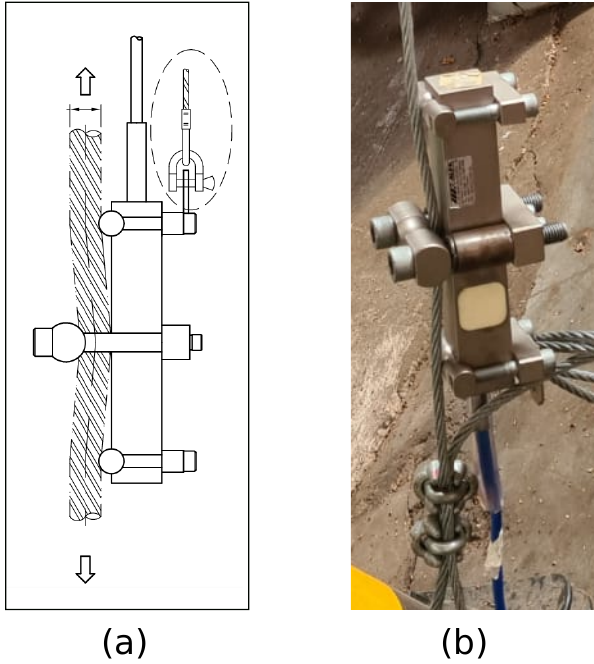
Figure 9. The tension sensor: ( a ) diagram and ( b ) actual